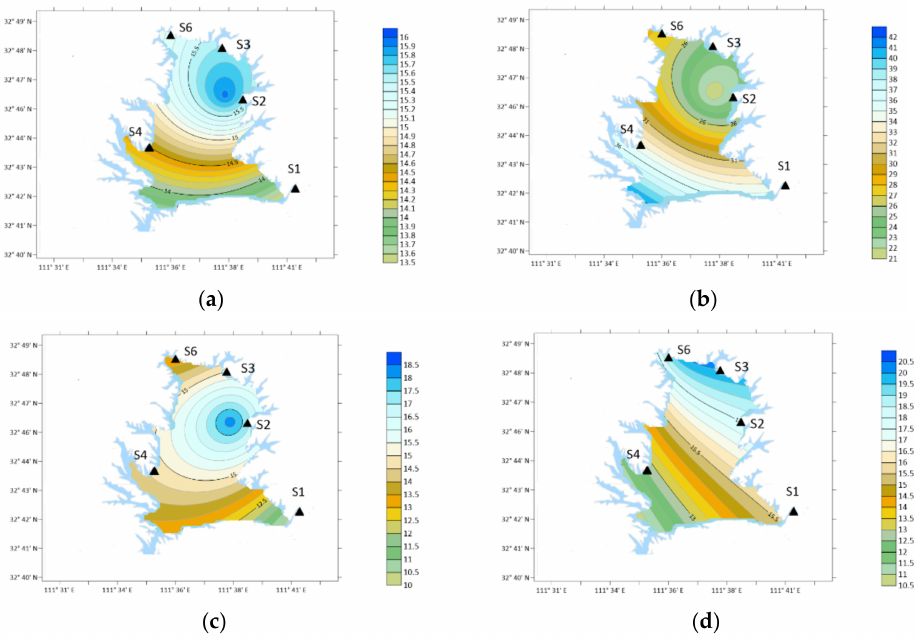
Figure 10. Spatial variation of PYR concentration. ( a ) Winter; ( b ) spring; ( c ) summer; ( d )